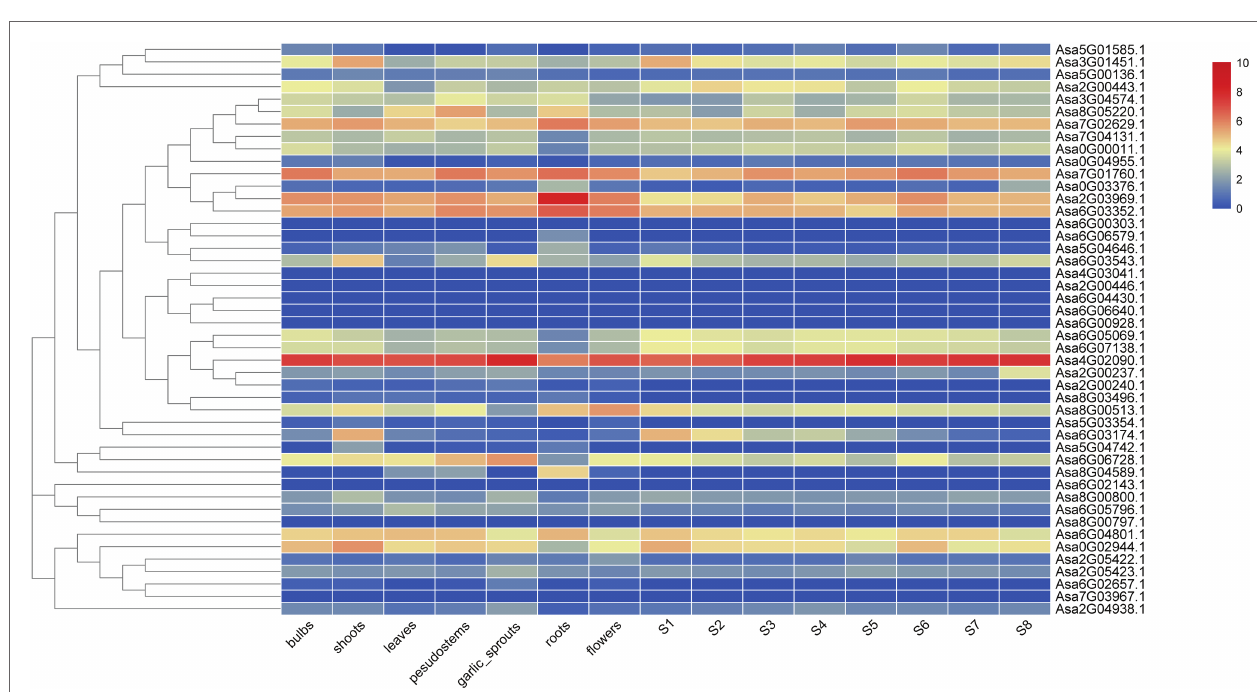
FIGURE 3 | Phylogenetic relationship, gene structure analysis, and motif distribution of garlic GRAS genes. (A) Conserved domain structures of 46 AsGRASs . (B) Amino acid motifs in the AsGRAS proteins are represented by colored boxes. The black lines indicate relative protein lengths. (C) Exons and introns are indicated by rectangles and gray lines, respectively.